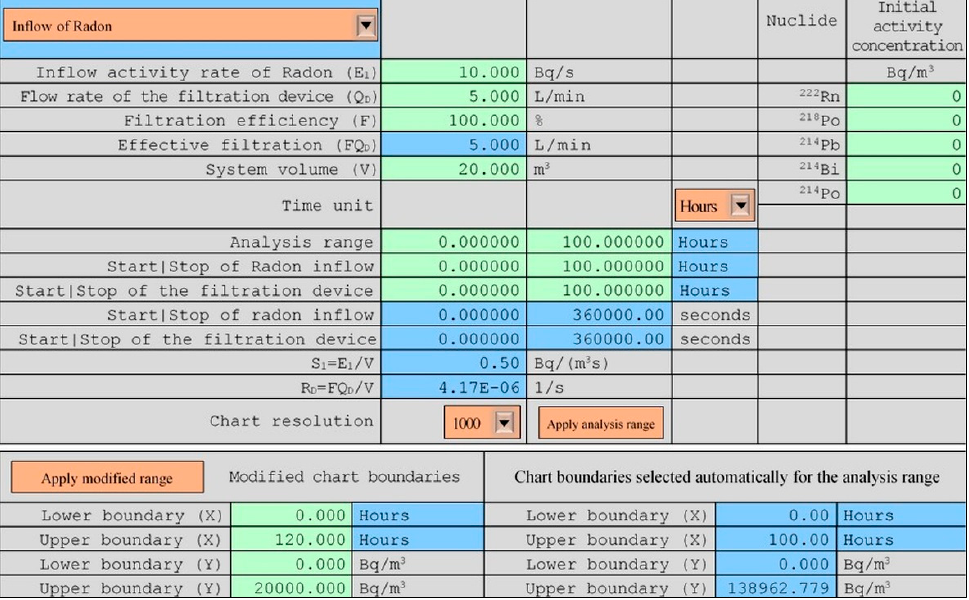
Figure 3. User interface. The meaning of the colors is as follows: the orange objects are the forms controls of the excel developer, the blue cells contain the rules, and should be not changed, and the green cells are designated for a user, who can introduce there the needed values.